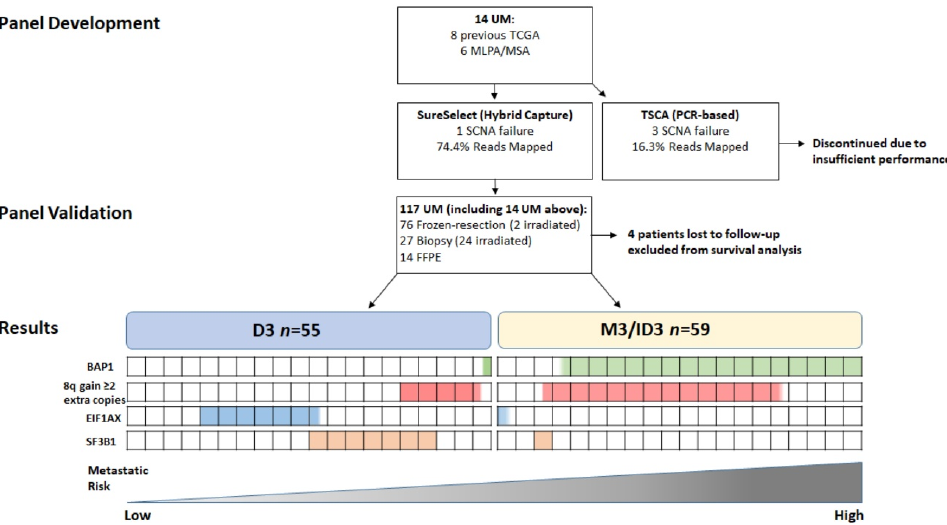
Figure 1. Flowchart of 117 UM specimens examined in the present study: n = 76 frozen-resection (2 post-irradiation); n = 27 Biopsy (24 post-irradiation); n = 14 FFPE. Four patients were lost to follow-up and excluded from survival analysis. n = 55 were D3, and n = 59 were M3 or ID3. Proportion of cases with the genetic alteration listed are highlighted by the coloured boxes. Each box represents 5% of UM patients